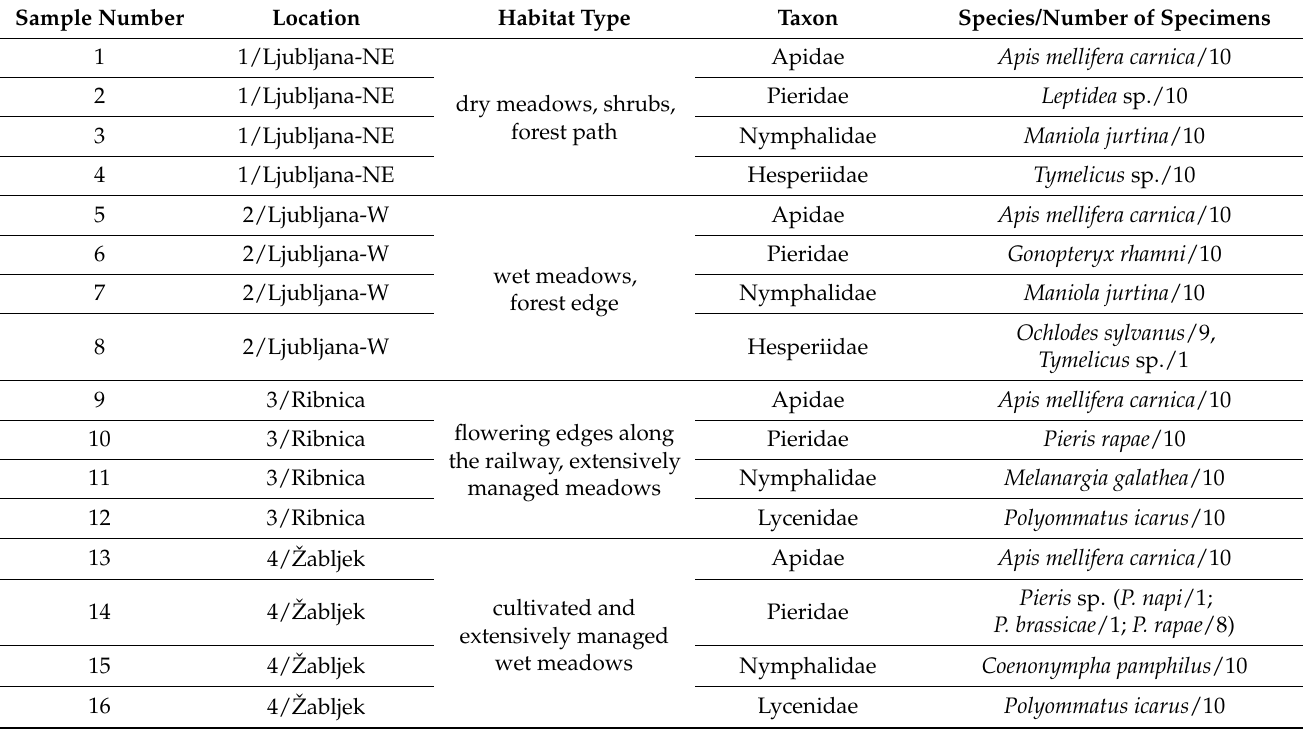
Table 1. List of butterfly samples by location, habitat type, taxon, and species/genus/family. At each of the four locations, 10 visually healthy honeybees of the species Apis mellifera carnica were sampled on the flowering plants in the same way as the butterflies (sample numbers 1, 5, 9 and 13). Legend: Ljubljana-NE = north-eastern part of the periphery of Ljubljana (46.087191, 14.553941); Ljubljana-W = western part of the periphery of Ljubljana (46.053369, 14.467093); Ribnica = town in the southern part of Slovenia (45.718746, 14.776496); Žabljek = village in the eastern part of Slovenia (46.350380,